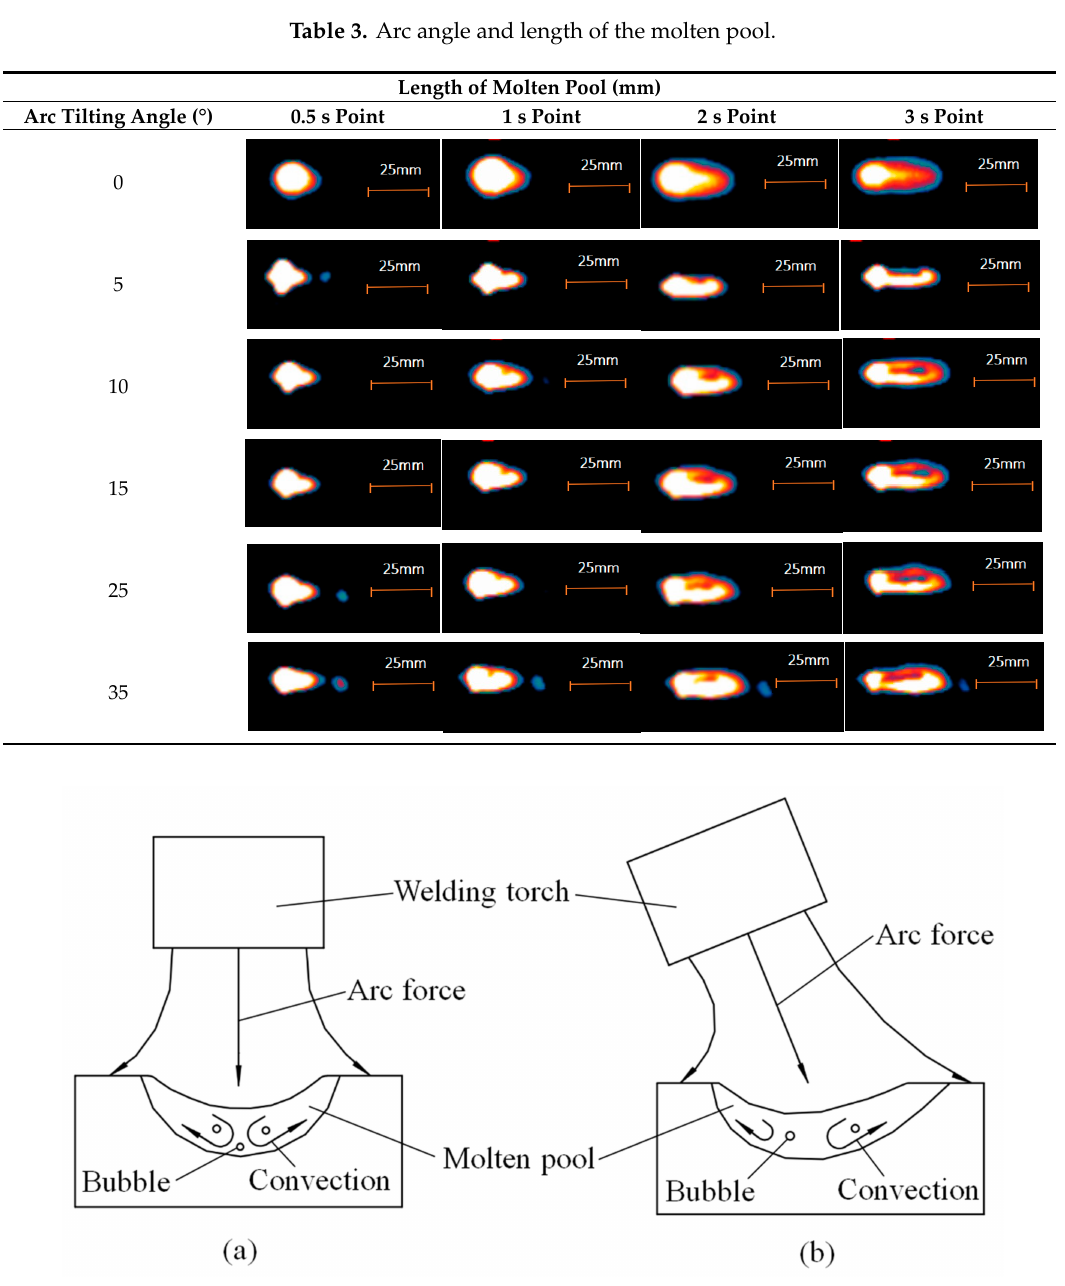
Figure 8. Schematic diagram of the flowing molten metal in molten pool ( a ) arc vertical of the welding surface, ( b ) arc tilt of the welding